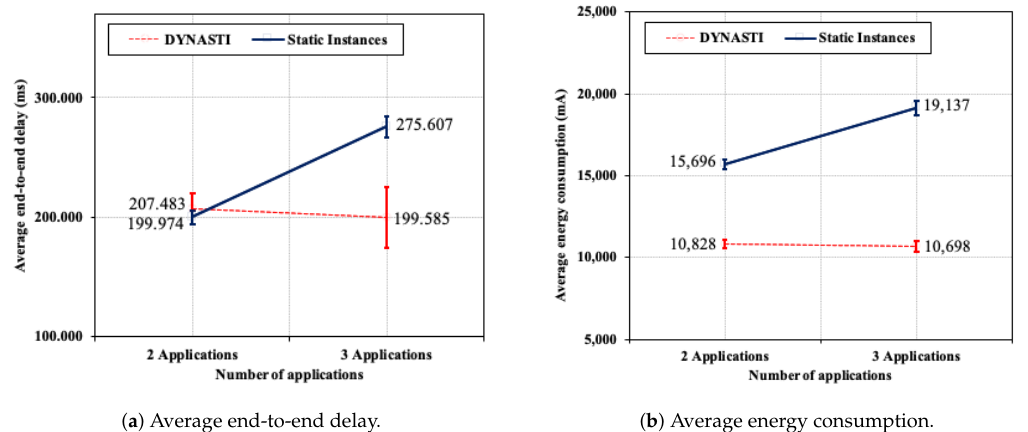
Figure 11. Average end-to-end delay and average energy